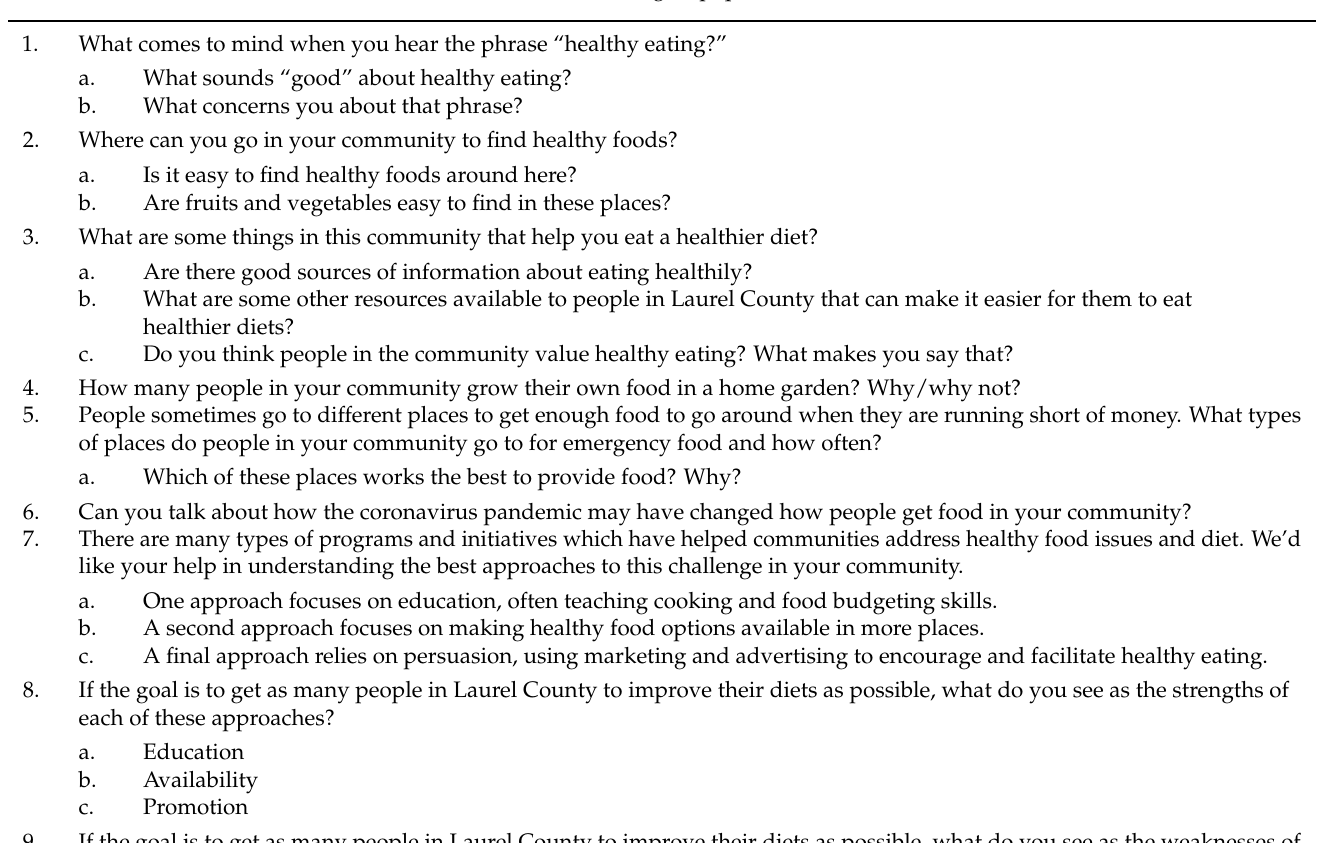
Table 1. Focus group